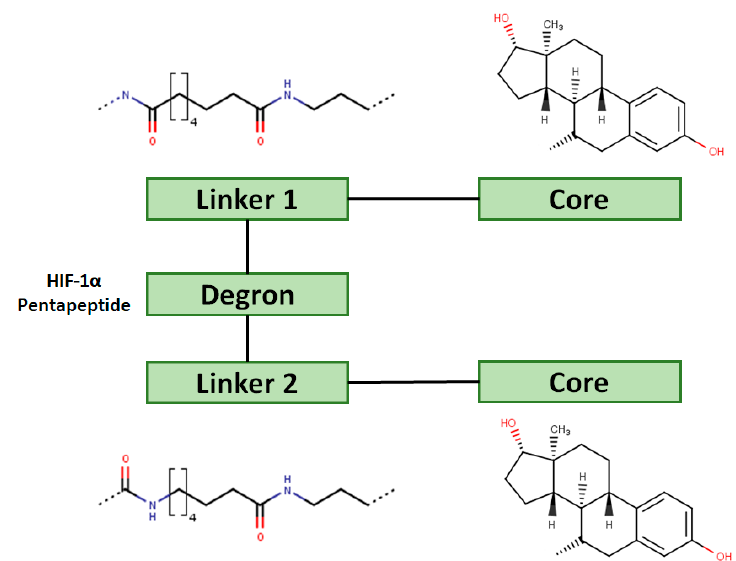
Figure 11. A double headed PROTAC with two E2s to bind to proteins with a common degron developed by Kim et al. [274].